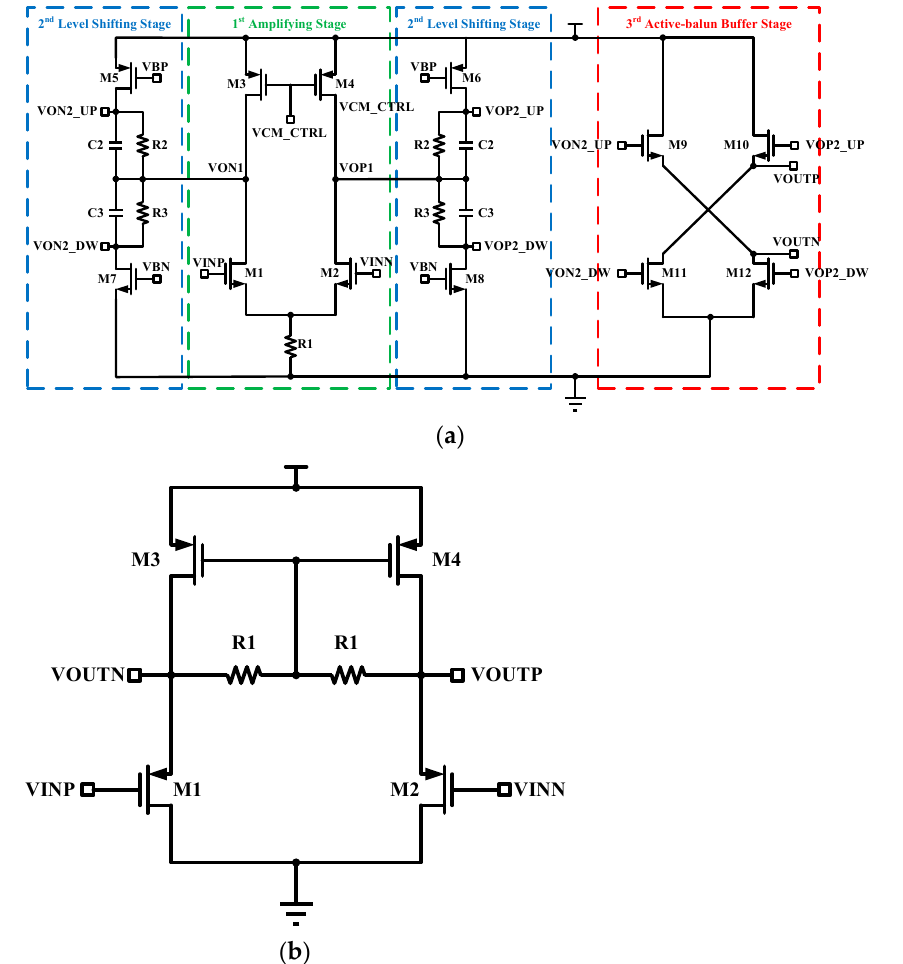
Figure 9. OPAMP and buffer in active loop filter. ( a ) OPAMP schematic; ( b ) buffer schematic.